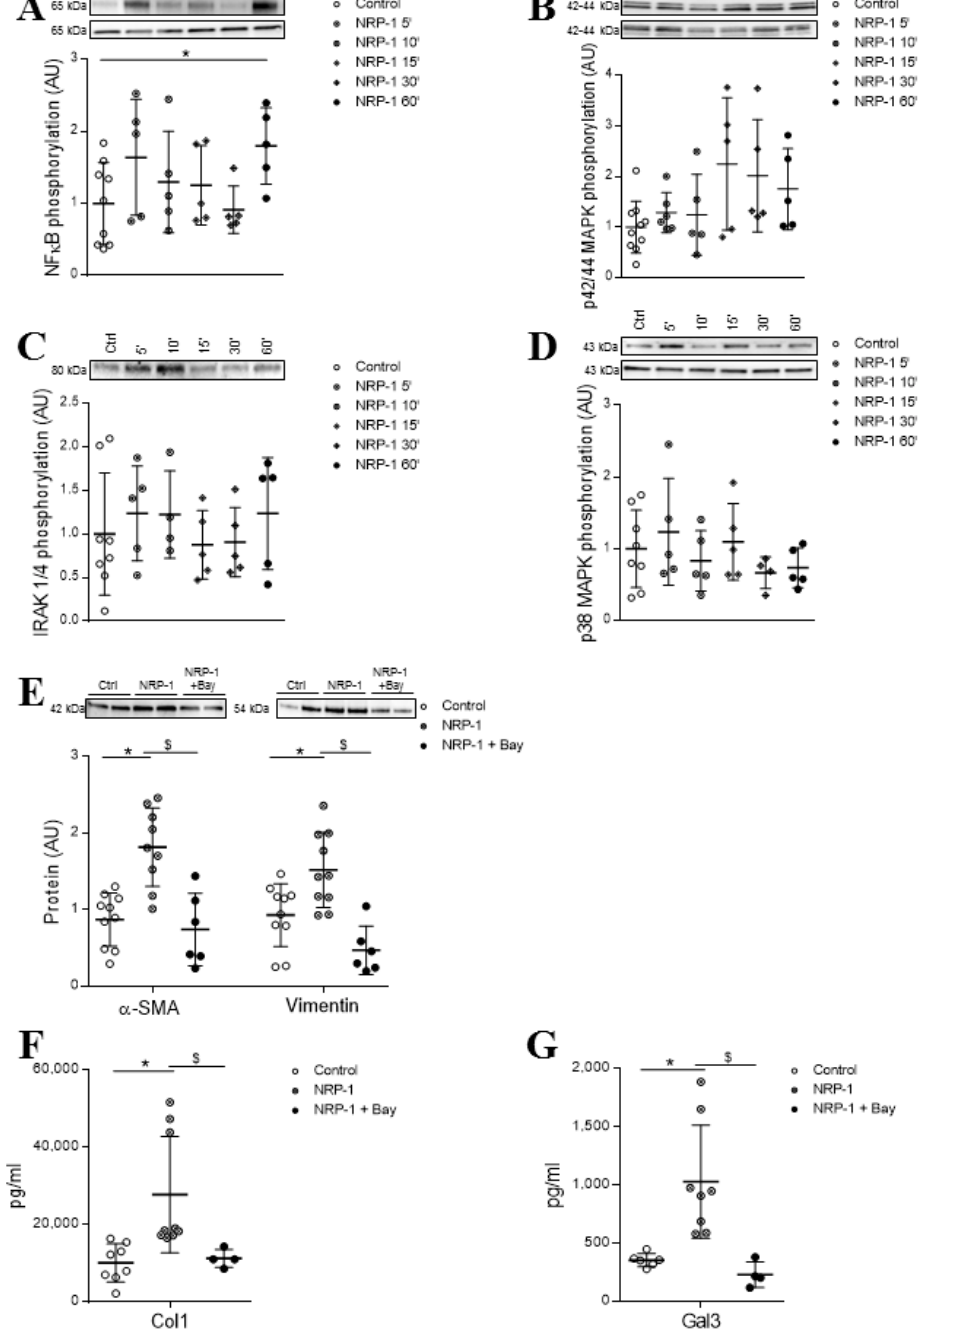
Figure 5. NRP-1 signaling pathways involved in its profibrotic e ff ects in HCFs. E ff ect of 10 − 8 M NRP-1 on NF- κ B ( A ), p42 / 44 MAPK ( B ), IRAK 1 / 4 ( C ) and p38 MAPK ( D ) phosphorylation. E ff ect of NRP-1 inhibition on fibroblast activation markers α -SMA and vimentin ( E ) and profibrotic markers Col-1 ( F ) and Gal-3 ( G ). Scatter dot blot represents the median and minimum to a maximum range of N = 4-10 replicates per condition. Protein phosphorylated upper and total protein expression lower. For Western blot experiments, protein densitometry was expressed in arbitrary units (AU) once normalized to stain-free for proteins. Representative blots have been displayed when appropriate. * p < 0.05 vs. control group. $ p < 0.05 vs. NRP-1. α -SMA, alpha smooth muscle actin; Col-1, collagen type I and Gal-3, galectin 3.